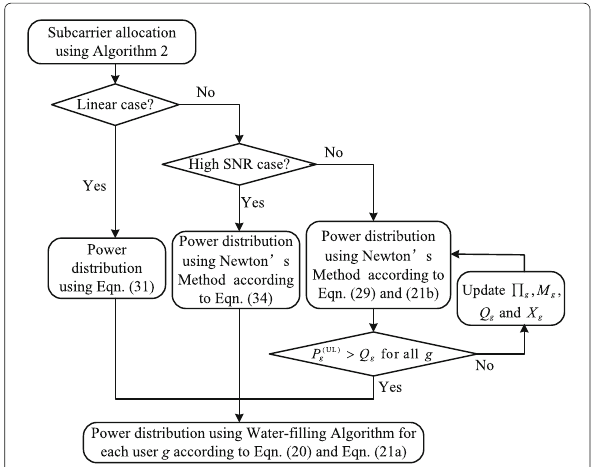
Fig. 3 Proposed resource allocation algorithm for the relay phase